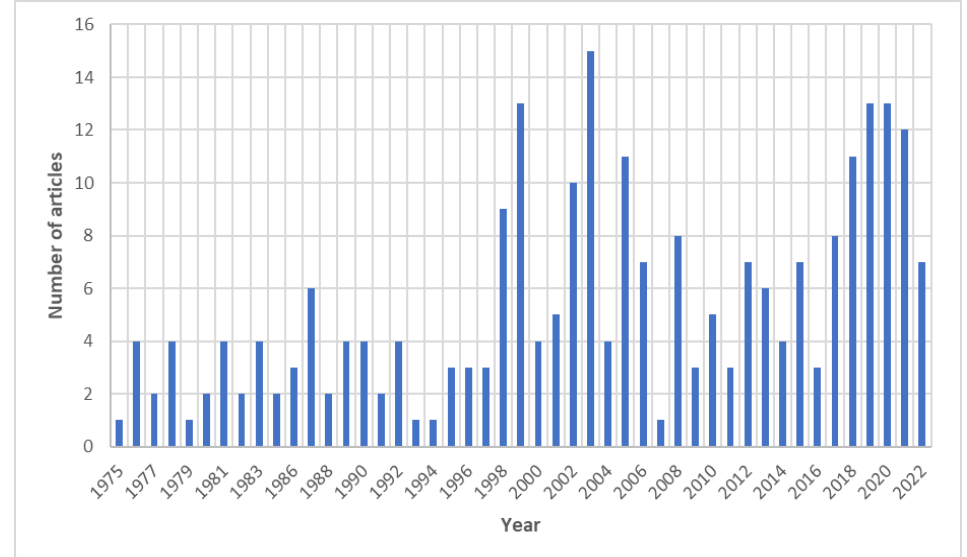
Figure 1. Evolution of the publication of articles on noma in the Web of Science from 1975 up to 10 July 2022.